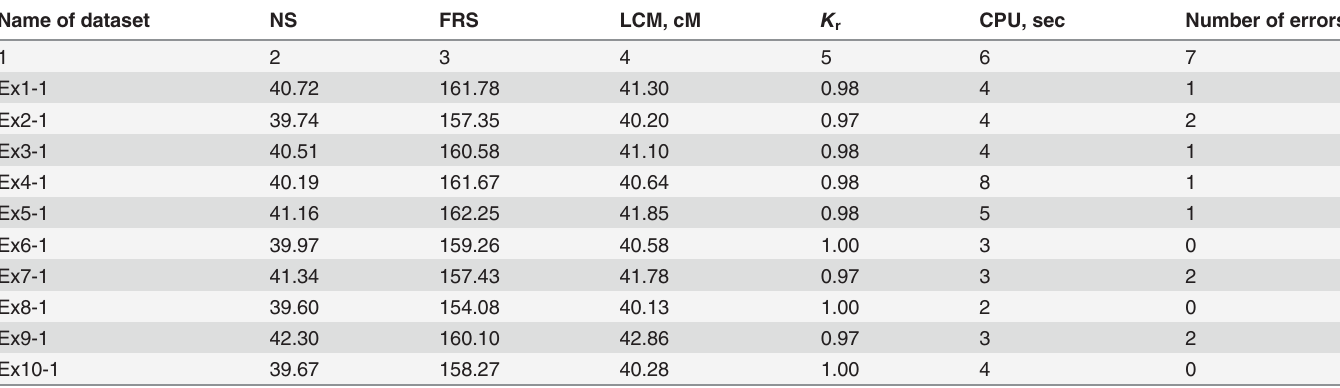
Table 1. Testing the proposed algorithm on datasets of Group 1. Name of dataset